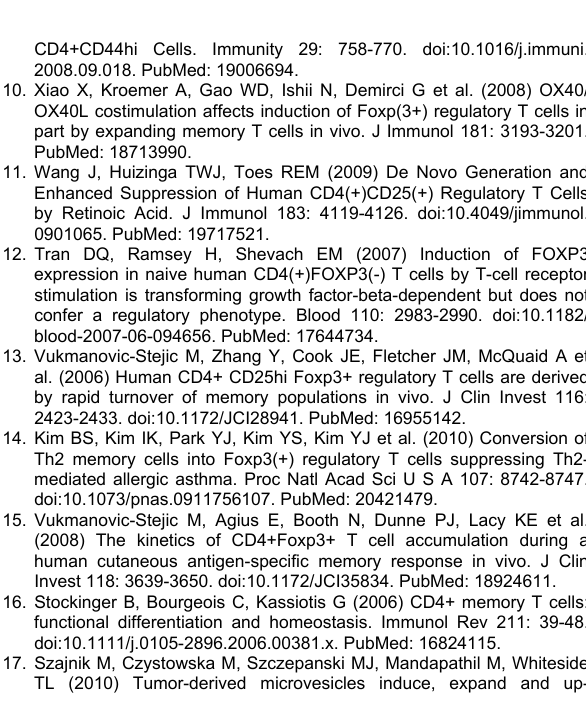
(TIF) Figure S3. Suppressive functions of Foxp3 + T cells derived from human CD4 + CD62L + central memory cells. ‘Treg’ indicates sorted CD4 + CD25 high T cells, ‘Foxp3 + Tn’, ‘Foxp3 + T ’ and ‘Foxp3 + T ’ indicate in vitro TGF-β-induced cm em Foxp3 + cells from naive, CD62L + T and CD62L - T CD4 + cm em cells, respectively. CFSE-labelled allogeneic CD4 + CD25 - T cells (2.5×10 4 cells/well) cultured alone or mixed with different ratios of suppressor cells (1:0, 1:1 and 2:1) were activated with anti-CD3 (5 μg/ml) and APCs (5×10 4 cells/well) in 96-well plates for 5 days. The suppressor cells were derived from naive, CD62 + T and CD62L + T cells that were induced to cm em differentiate by the addition of TGF-β. (TIF) Table S1. Information for the human samples.